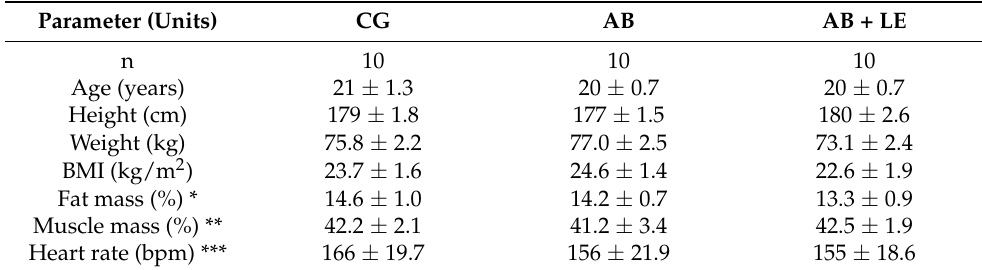
Table 1. Age, anthropometric parameters determined at the moment of recruitment (Day 1) and mean heart rate during the match (Day 22) determined in the field for players in control (CG), almond beverage (AB) and almond beverage + Lippia extract (AB + LE) groups. Parameter (Units) CG AB AB + LE n 10 10 10 Age (years) 21 ± 1.3 20 ± 0.7 20 ± 0.7 Height (cm) 179 ± 1.8 177 ± 1.5 180 ± 2.6 Weight (kg) 75.8 ± 2.2 77.0 ± 2.5 73.1 ± 2.4 BMI (kg/m 2 ) 23.7 ± 1.6 24.6 ± 1.4 22.6 ± 1.9 Fat mass (%) * 14.6 ± 1.0 13.3 ± 0.9 Muscle mass (%) ** 42.2 ± 2.1 41.2 ± 3.4 42.5 ± 1.9 Heart rate (bpm) *** 166 ± 19.7 156 ± 21.9 155 ±